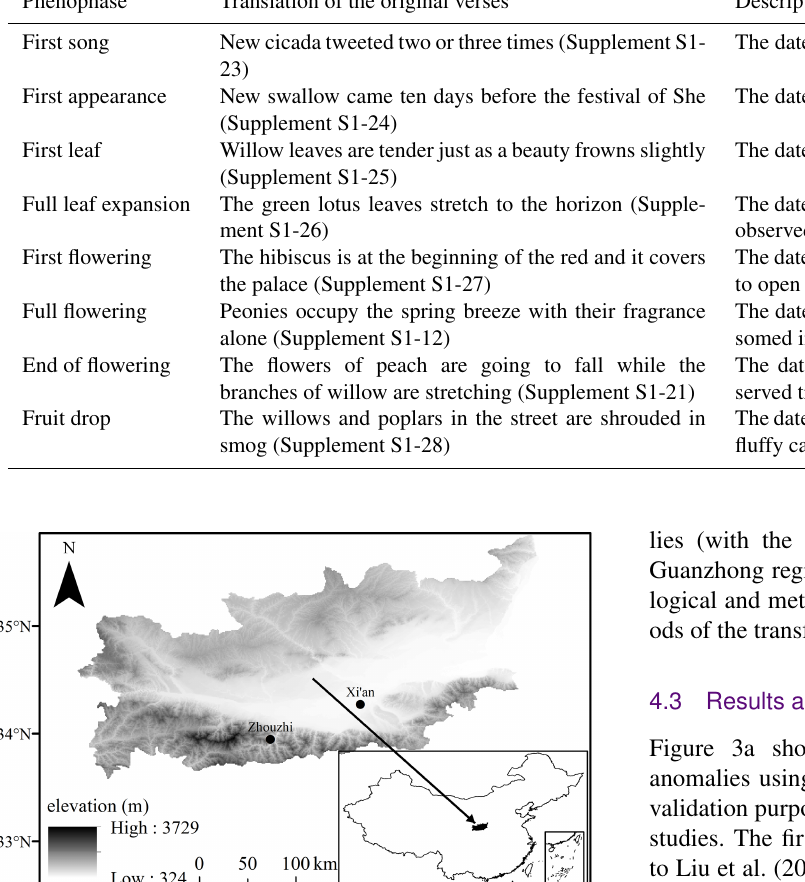
Table 5. Classification and grading results for representative examples of phenological descriptions in poems. Phenophase